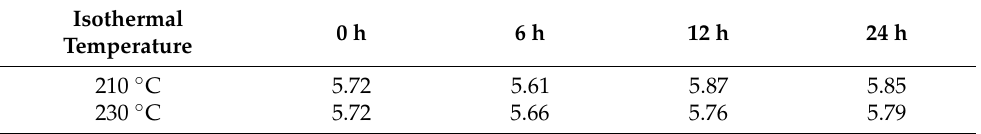
Table 4. Volume fraction of undissolved carbides under different isothermal processes,